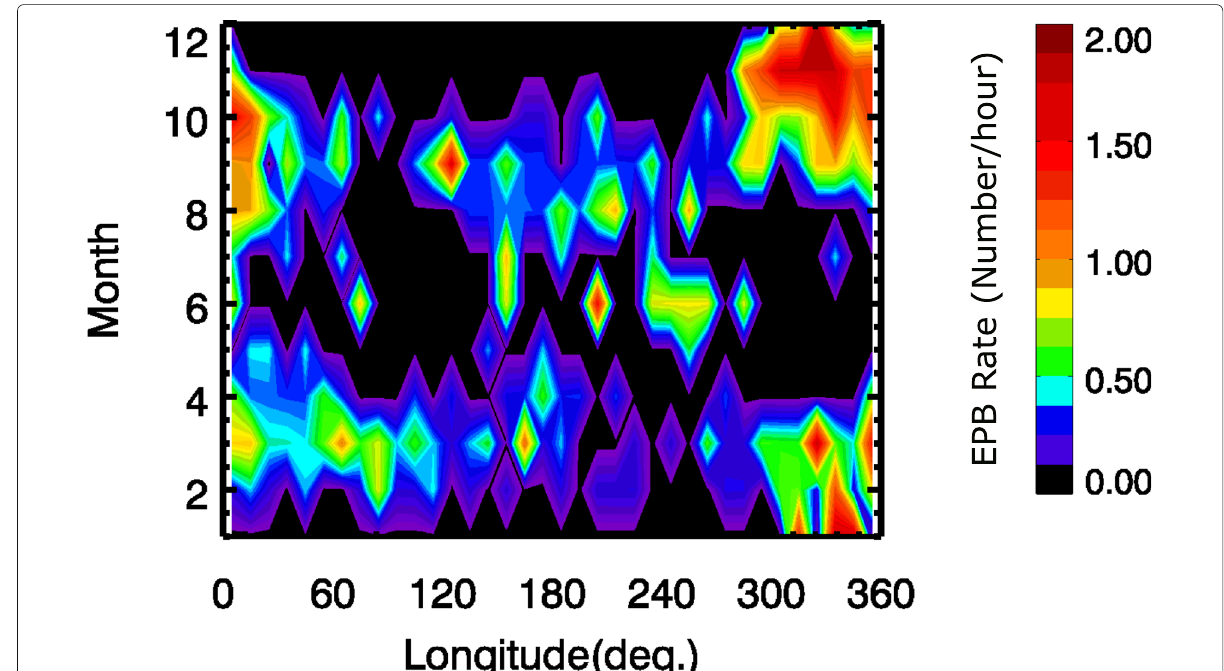
Fig. 3 The occurrence rate of EPBs observed by the VISI